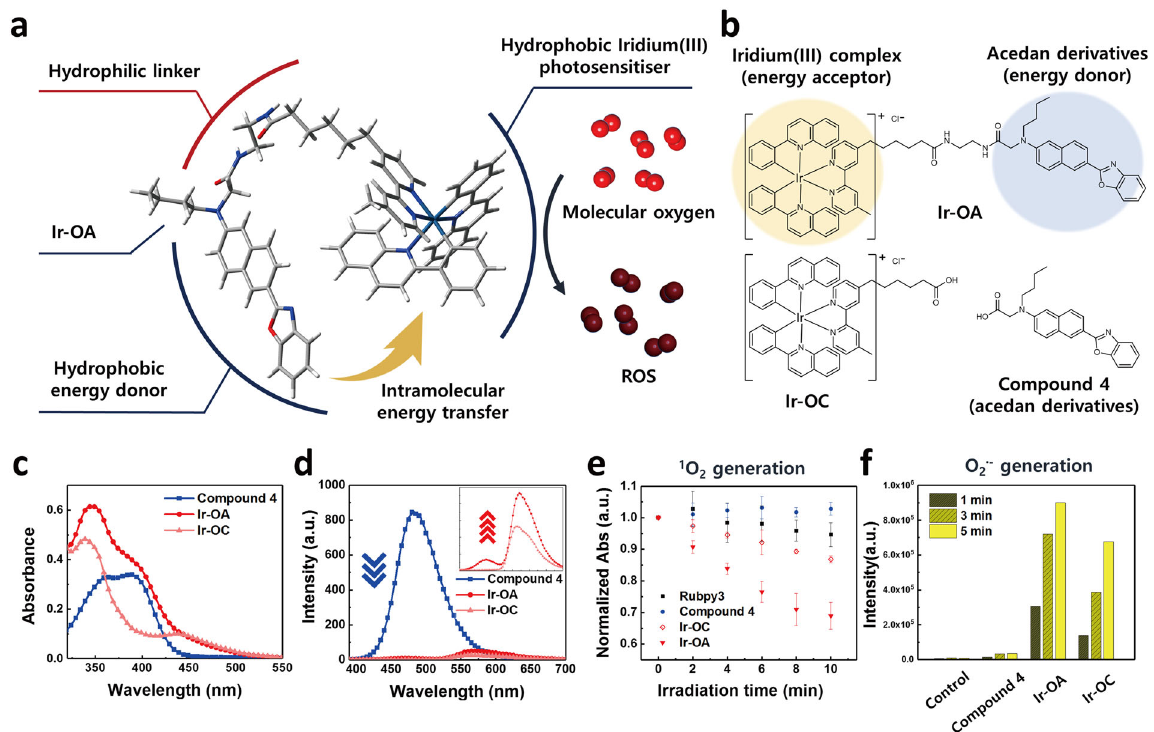
Fig. 1 Photophysical characterisation of iridium(III) photosensitiser. a Schematic illustration of the molecular engineering strategy: intramolecular energy transfer and resulting photoactivated ROS generation. The illustrated Ir-OA molecule is a Δ isomer, but the Λ form enantiomer can exist. b Molecular structure of Ir-OA, Ir-OC, and compound 4. c UV-vis absorption spectrum of the three presented chemicals. d Subsequent emission spectra ( λ ex = 400 nm) of the three chemicals. Magni fi ed emission spectra show the enhanced emission of Ir-OA compared with that of Ir-OC, which reveals the evidence of energy transfer. Conditions for the absorption and emission spectra; [Ir-OA or Ir-OC or compound 4] = 20 μ M in H 2 O:DMSO = 99:1 (v/v%). e 1 O 2 assay using the absorbance decay of 9,10-anthracenediyl-bis(methylene)dimalonic acid (ABDA) under light exposure. The ABDA is degraded by 1 O 2 produced by photoactivation of the Ir-OA. Data are presented as mean value ± s. d. ( n = 3). f O 2 • – assay using the fl uorescence enhancement of dihydrorhodamine 123 (DHR123). DHR123 is oxidised to rhodamine123 by the produced O 2 • – , which enhances fl uorescence signal. Conditions for ROS assays: [iridium(III) complexes] = 4 μ M; [ABDA] = 100 μ M or [DHR123] = 4 μ M in H 2 O:DMSO = 999:1 (v/v%). Source data are provided as a Source Data fi